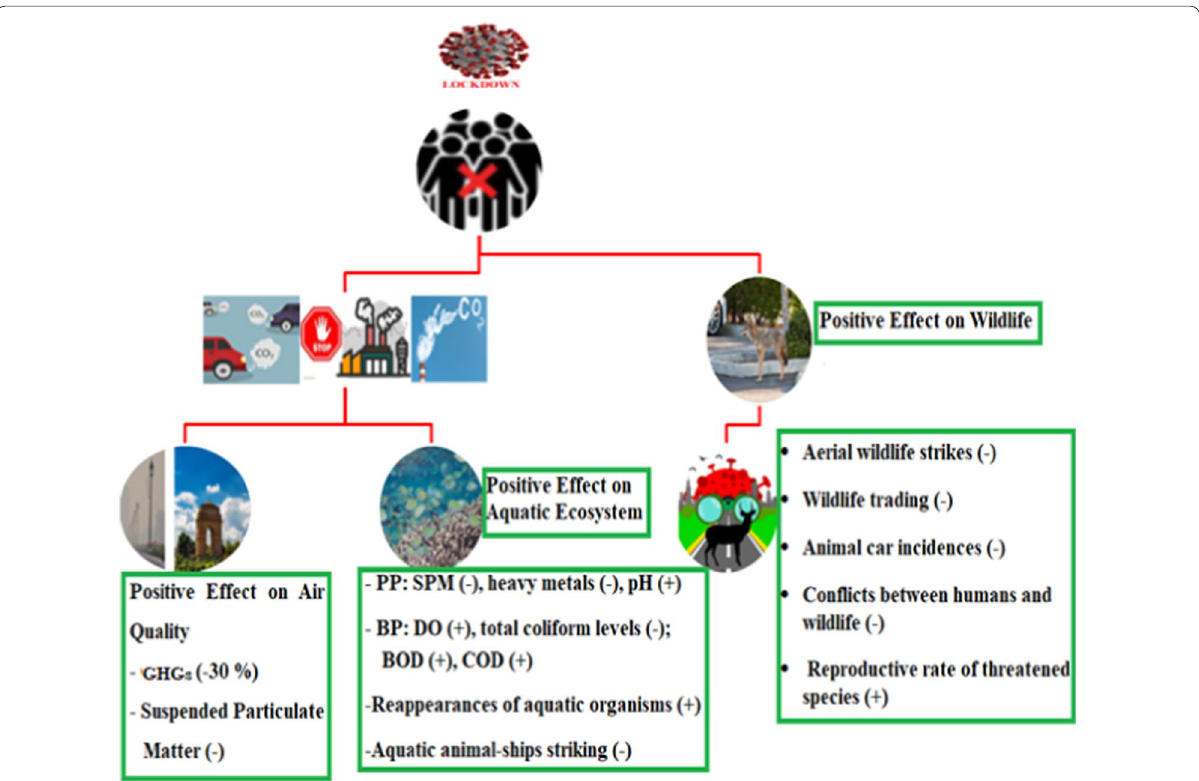
Fig. 4 The positive effect of COVID-19 lockdown on environmental management and biodiversity management operations, ( increasing trends and ( ) reduction. GHGs; Greenhouse Gases; PP, Physical Parameter; SPM, Suspended Particulate Matter; pH, Power of Hydrogen; − BP, Biological Parameter; DO, Dissolved Oxygen; BOD, Biological Oxygen Demand; COD, Chemical Oxygen